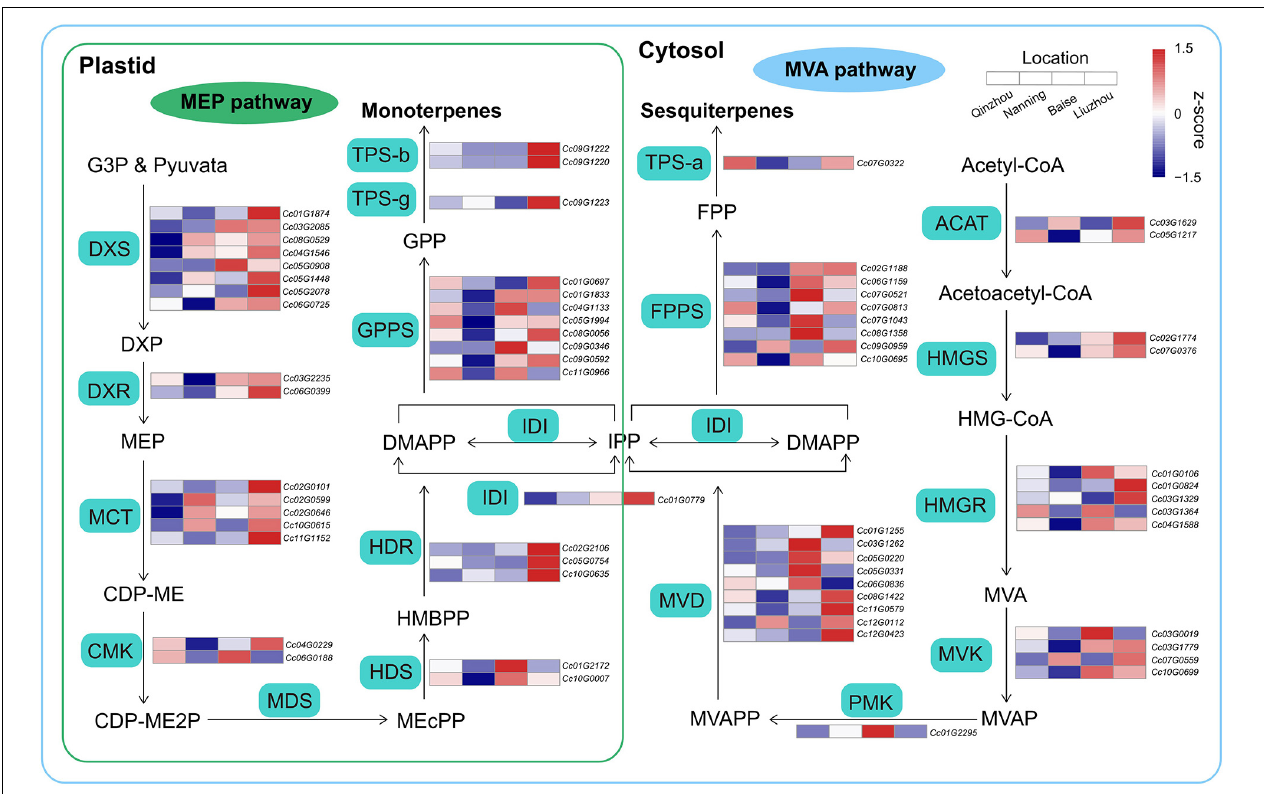
FIGURE 6 | Biosynthetic pathways of monoterpenoids and sesquiterpenoids. Relative expression profiling of genes involved in volatile terpenoid biosynthesis among the four planting locations (Qinzhou, Nanning, Baise and Liuzhou). Gene expression was extracted from the combined differentially expressed gene (DEG) set (Liuzhou vs. Qinzhou, Liuzhou vs. Nanning, Baise vs. Qinzhou and Baise vs. Nanning). MEP, mevalonate pathway; MEP, methylerythritol phosphate pathway; ACAT, acyl-coenzyme A-cholesterol acyl-transferase; HMGS, hydroxymethylglutaryl coenzyme A synthase; HMGR, hydroxymethylglutaryl coenzyme A reductase; MVK, mevalonate kinase; PMK, phospho-mevalonate kinase; MVD, mevalonate diphosphate decarboxylase; DXS, 1-deoxy-D-xylulose 5-phosphate synthase; DXR, 1-deoxy-D-xylulose 5-phosphate reductoisomerase; MCT, 2-C-methyl-D-erythritol-4-phosphate cytidylyltransferase; CMK, 4-(cytidine-5-diphospho)-2-C- methyl-D-erythritol kinase; MDS, 2-C-methyl-D-erythritol-2,4-cyclodiphosphate synthase; HDS, (E)-4-hydroxy-3-methyl-but-2-enyl-pyrophosphate synthase; HDR, (E)-4-hydroxy-3-methyl-but-2-enyl-pyrophosphate